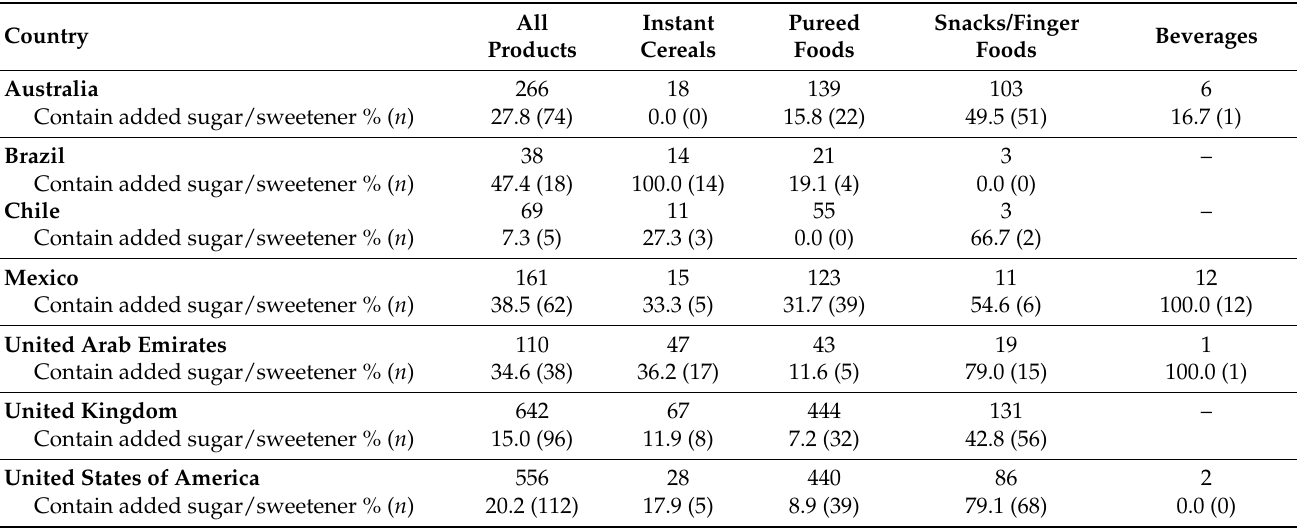
Table 3. Proportion of commercially produced complementary food products containing added sugar/sweetener, by product categories and country 1,2